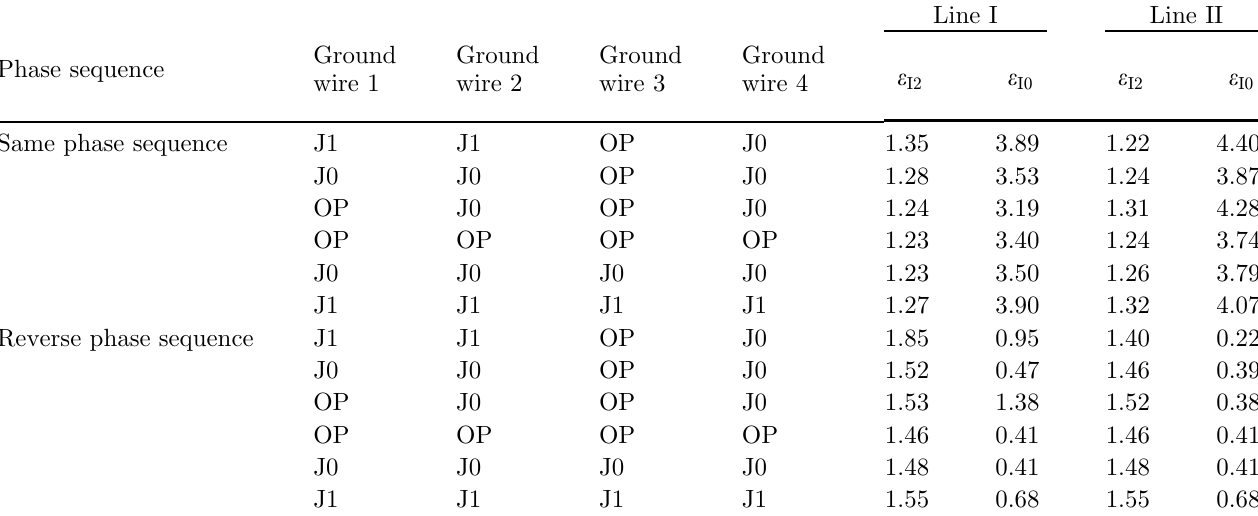
Table 8. The in fl uence of the ground wires on the current imbalance.